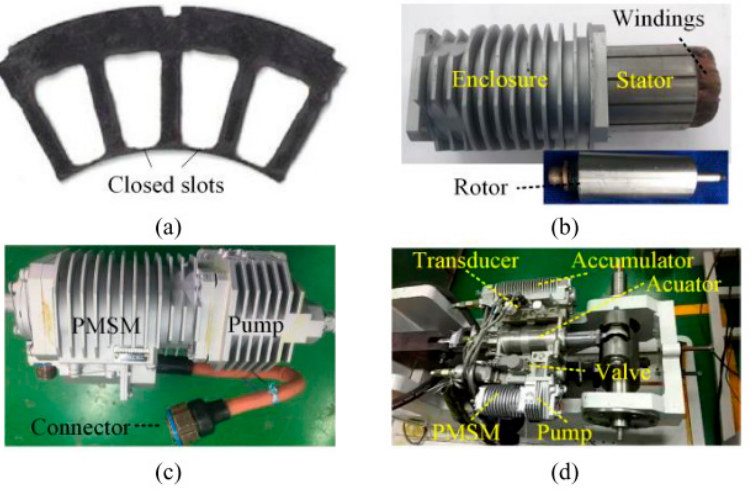
Figure 2. Photographs of the stator sheet, machine composition, machine and pump, and the EHA. ( a ) Stator sheet in PMSM. ( b ) Enclosure, windings, rotor and stator in PMSM component parts. ( c ) Energy supply system consisting of PMSM and axial piston pump. ( d ) EHA. Reprinted with permission from Ref. [23]. 2021, IEEE.